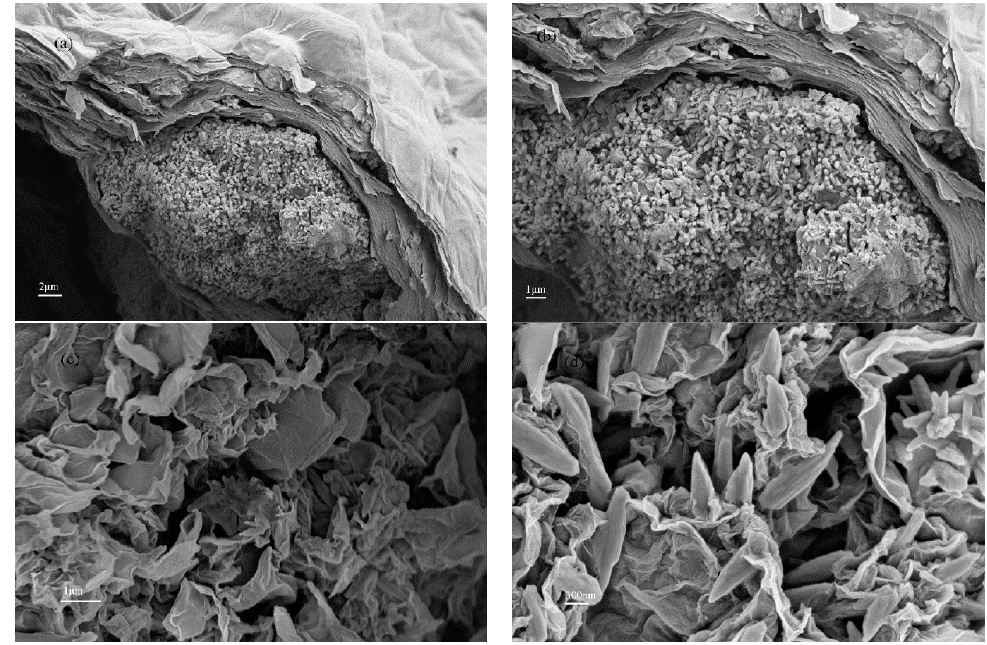
Figure 6. SEM images recorded for coagulation products of GO by cement (CPGC) for 10 h with different scale bar ( a ) 2 µ m; ( b ) 1 µ m; ( c ) 1 µ m; ( d ) 300 nm.